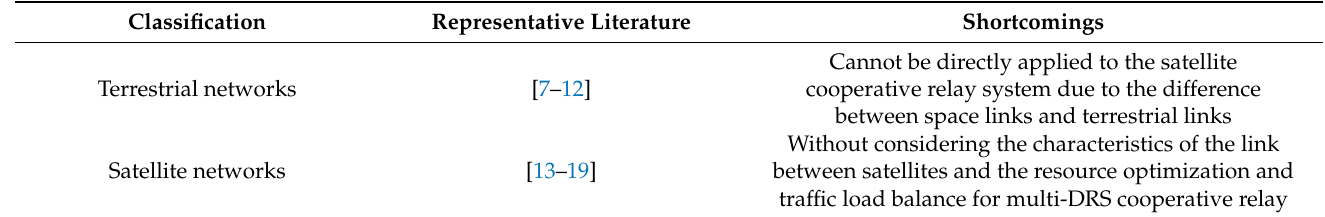
Table 1. Comparison of existing